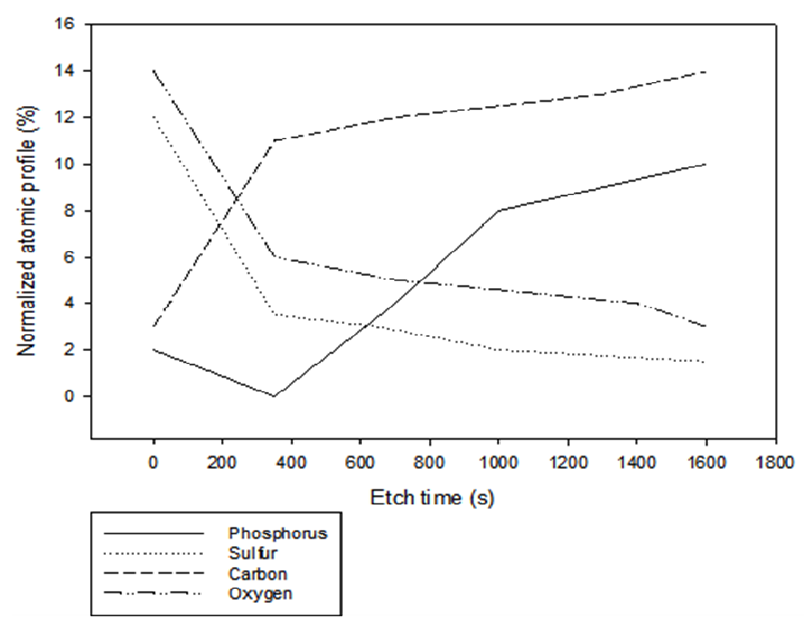
Figure 12. Depth-profile scan on phosphorene membranes.